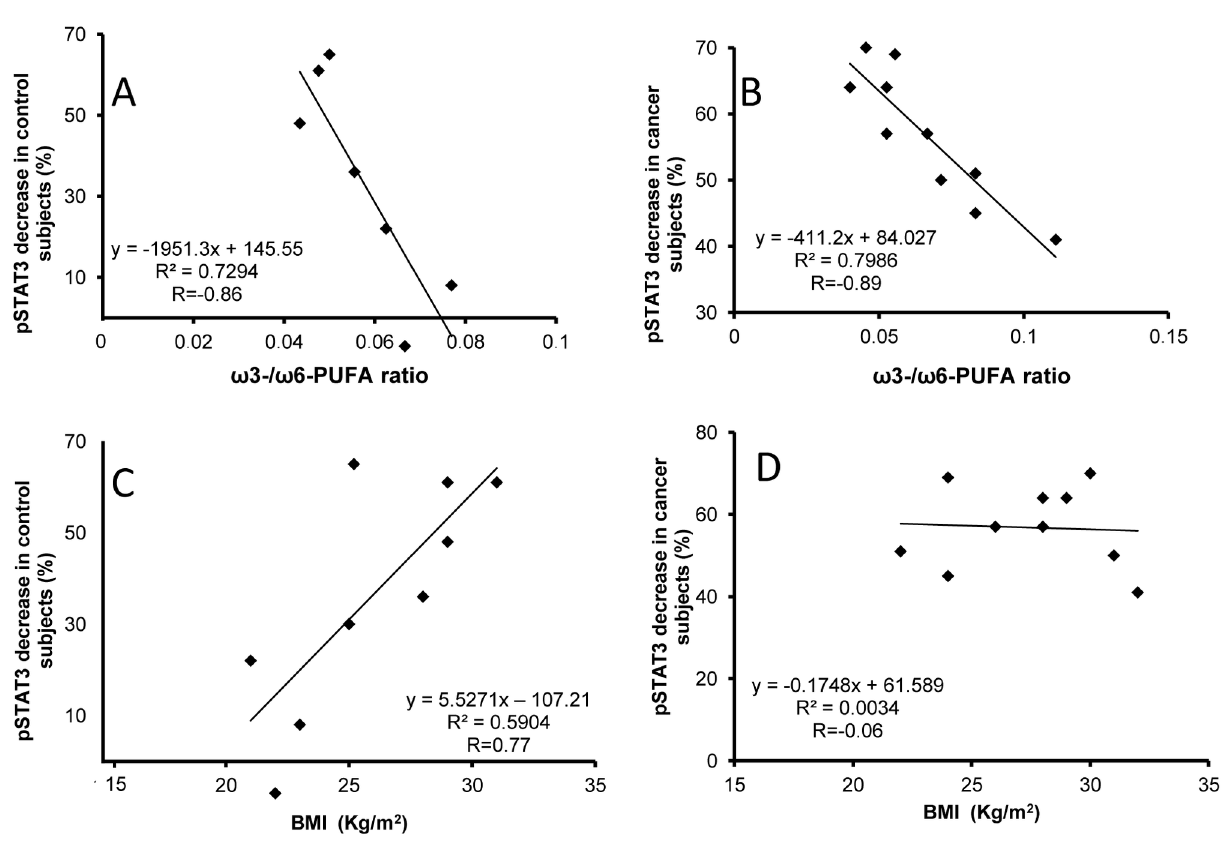
Figure 4. Linear regression analysis between ω3-/ω6-PUFA ratio, Body Mass Index (BMI) and pSTAT3 decrease. Correlation between the ω3-/ω6-PUFA ratio and the percentage of pSTAT3 decrease after DHA treatment in control subjects (n=10) ( A ) and cancer subjects (n=14) ( B ). Correlation between the BMI and the percentage of pSTAT3 decrease after DHA treatment in control subjects ( C ) and cancer subjects ( D